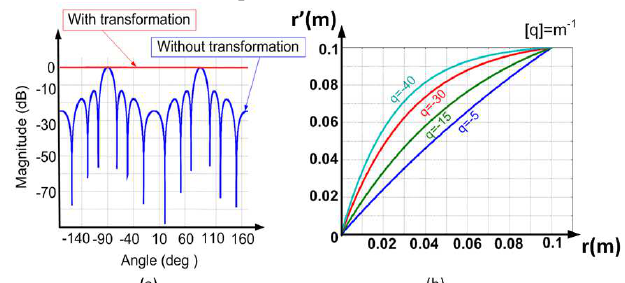
Figure 13: (a) Far field radiation pattern of the emission with ( q = -40 m -1 ) and without transformation. (b) Influence of the expansion parameter q on the proposed coordinate transformation. The emitted radiation is more and more isotropic as q tends to high negative